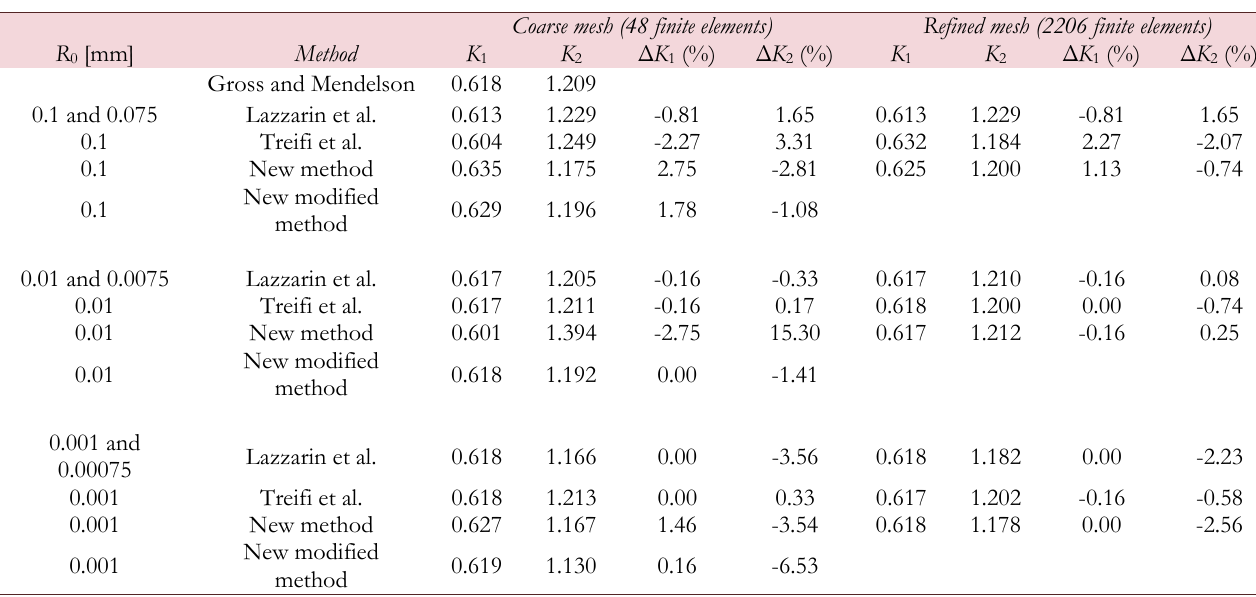
Table 3: Comparison between approximate methods for NSIFs evaluation of diamond-shaped notch (2 α = 90°). Coarse mesh (64 finite elements) Refined mesh (3395 finite elements)